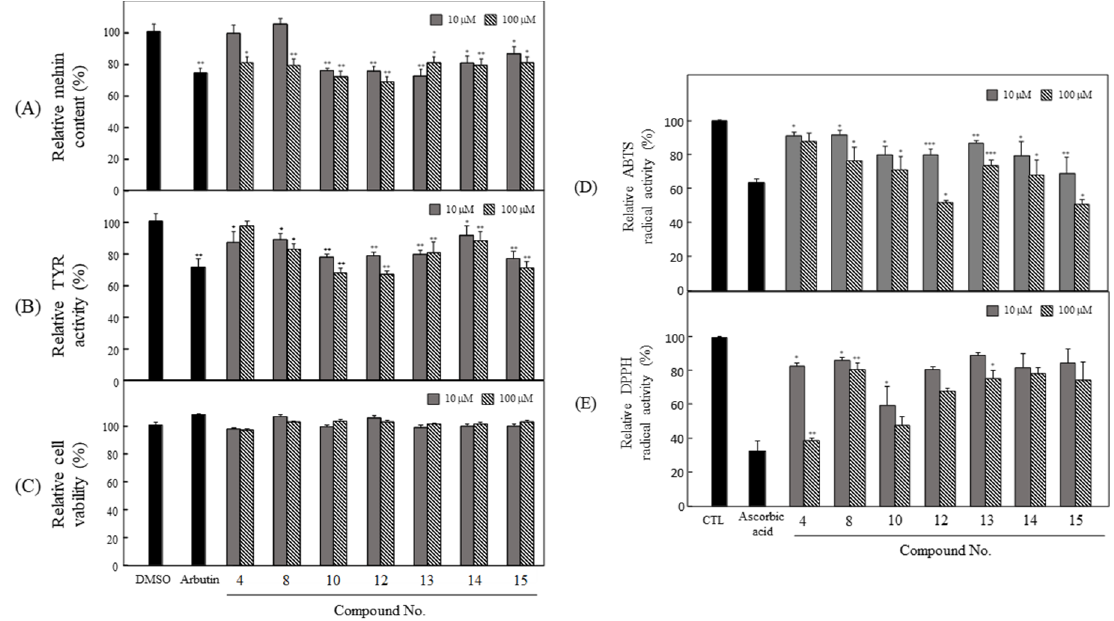
Figure 5. Anti-melanogenesis and antioxidant effects of seven compounds isolated from n -butanol fraction of PAL. ( A ) Melanin content, ( B ) TYR activity ( C ) cytotoxicity in B16F10. ( D ) ABTS and ( E ) DPPH radical-scavenging activities. The data are expressed as the mean ± SD ( n = 3) of three individual experiments. * p < 0.05, ** p < 0.01 and *** p < 0.001, compared with control.